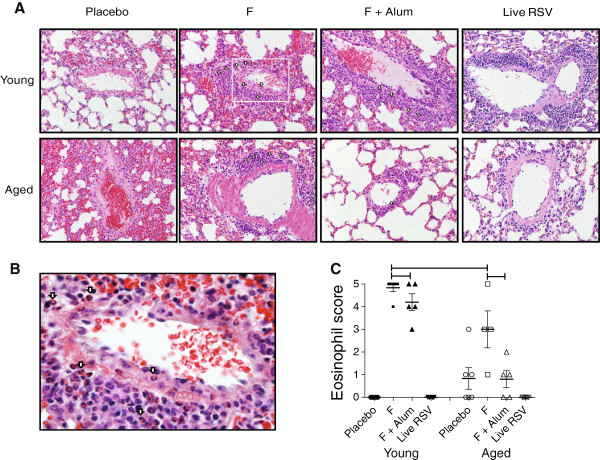
Local accumulation of eosinophils in young and aged mice. Vaccinated young and aged BALB/c mice were challenged with 106 PFU RSV A2 at day 28. (A) Lungs were harvested 4 days post-challenge, stained with H&E, and eosinophil infiltration was scored. Representative sections are shown. Arrows indicate eosinophils. (B) The boxed inset in Figure
4A shows eosinophils (arrows) at higher magnification. (C) Eosinophil score ± SEM. Each symbol represents one mouse. (Brackets, P < 0.05, ANOVA).